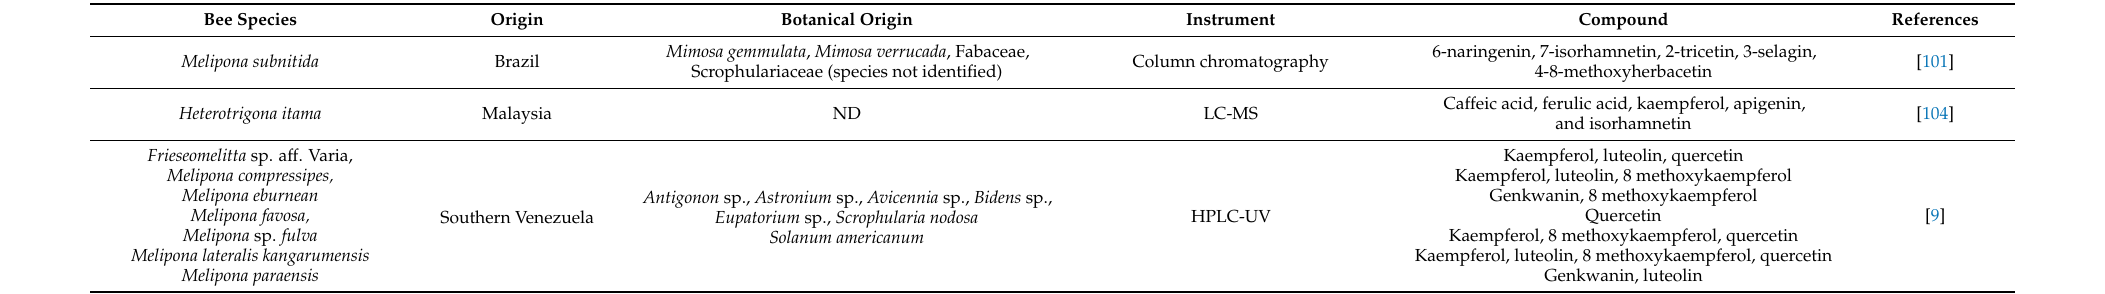
Table 4. Bioactive compounds in stingless bee bee